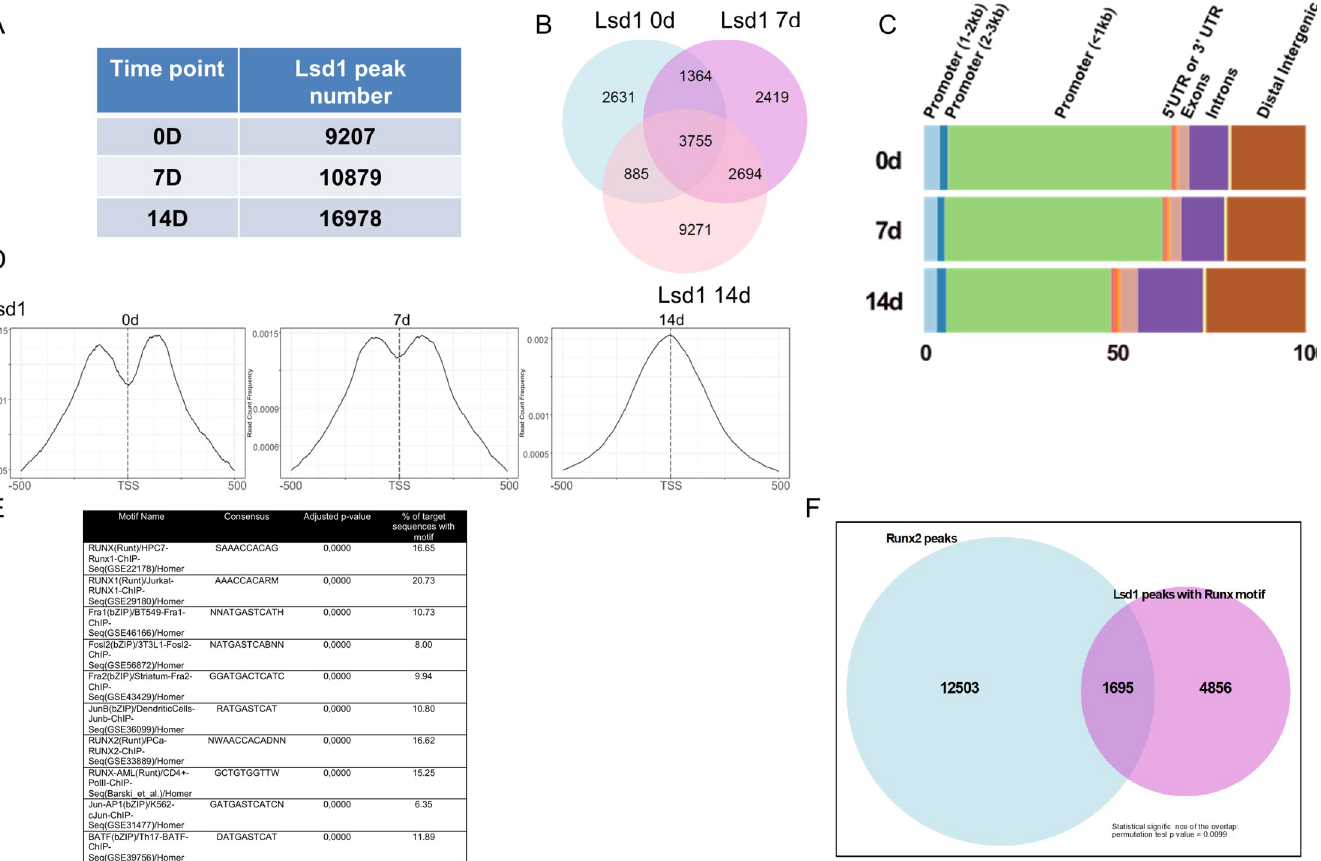
Fig 6. Lsd1 ChIP-seq analysis. (A) Number of Lsd1 peaks detected at different time points. (B) Overlap of Lsd1 peaks between different time points represened by Venn diagram. (C) Distrubution of Lsd1 peaks. (D) Distance of Lsd1 peaks from the TSS at different time points. (E) Top enriched TF consensus motifs in Lsd1 ChIP-seq peak data. (F) Overlap of Lsd1 and published Runx2 ChIP-seq